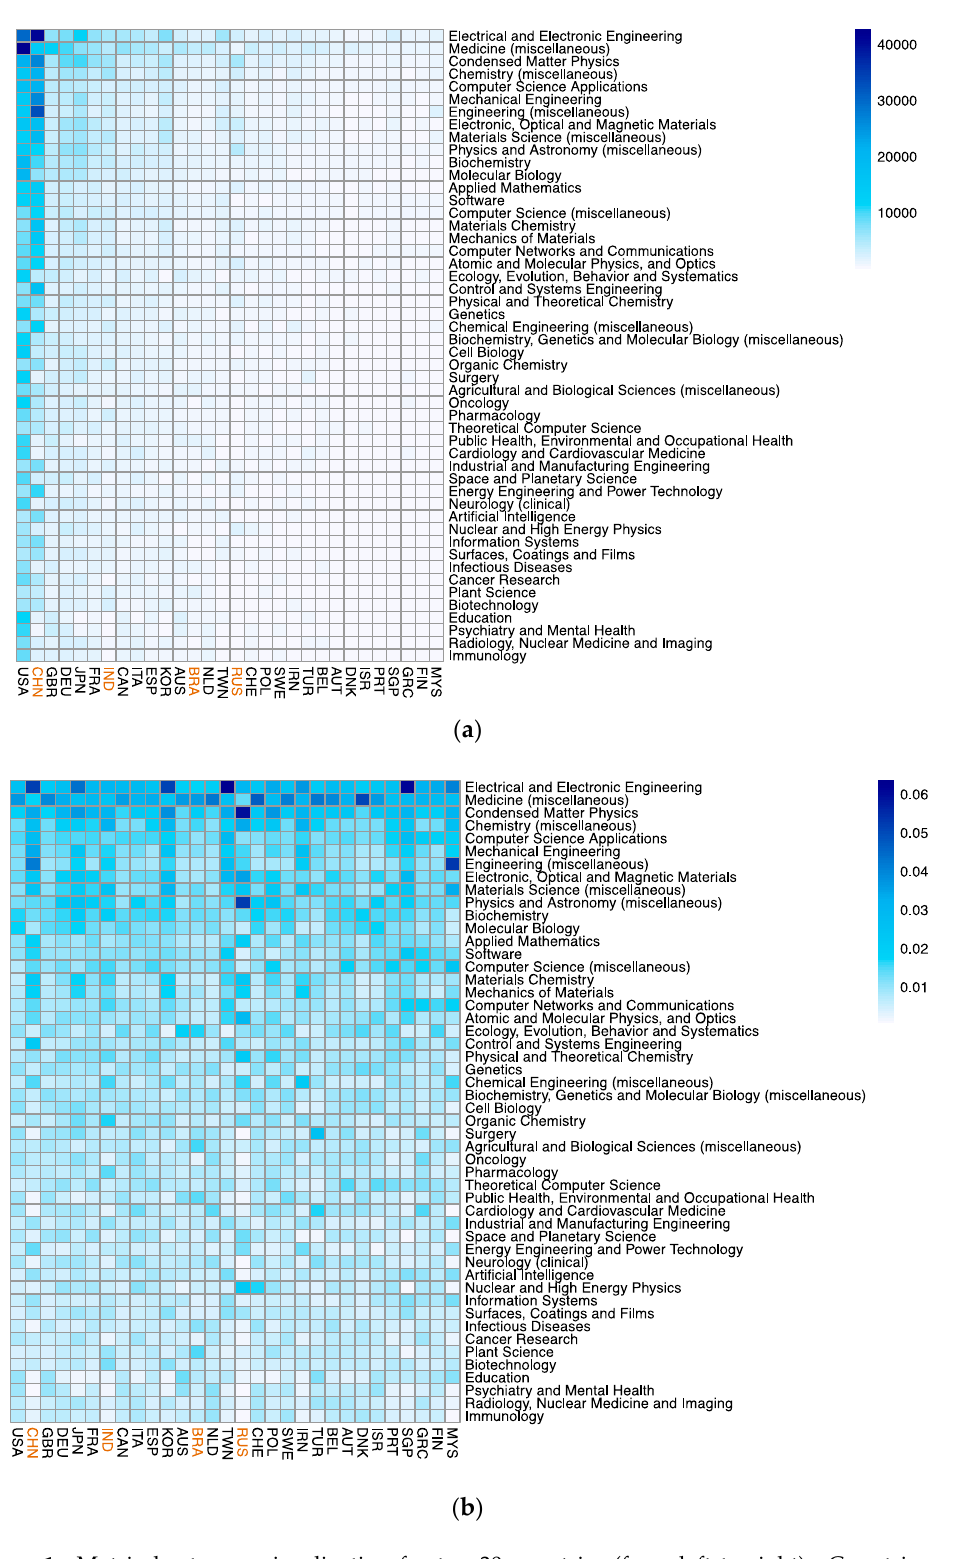
Figure 1. Matrix heat map visualization for top 30 countries (from left to right). Countries are ranked—from left to right—by the average values of authorships in the time interval between 2006 and 2015. Rows represent categories of science and columns represent countries. ( a ) Matrix where each entry represents the average values of authorships; ( b ) Matrix where each entry represents the “share” of each category in each